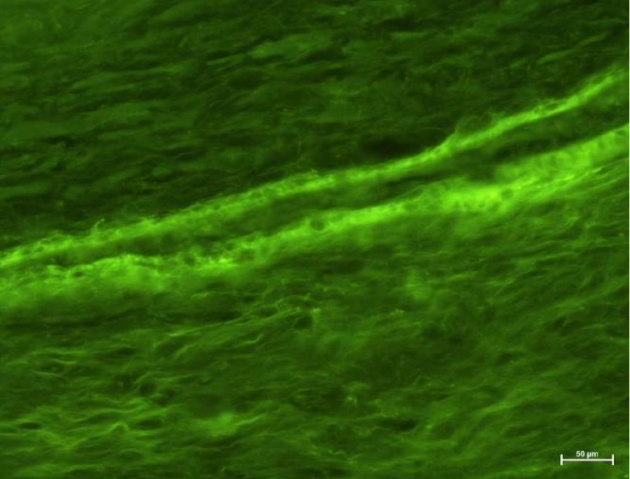
Figure 8. Fluorescence microscope image, human molar—Group IV. Typical angiogenesis with a new blood vessel formation in the dental pulp. UV-2A. Mag. 200 × .